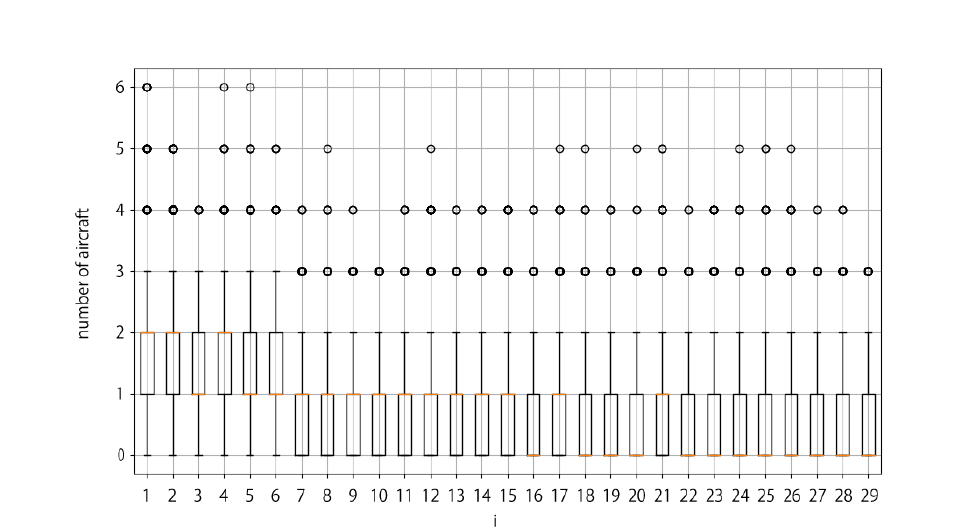
Figure 11. Data-driven estimate of the number of servers, c , for the G / G / c